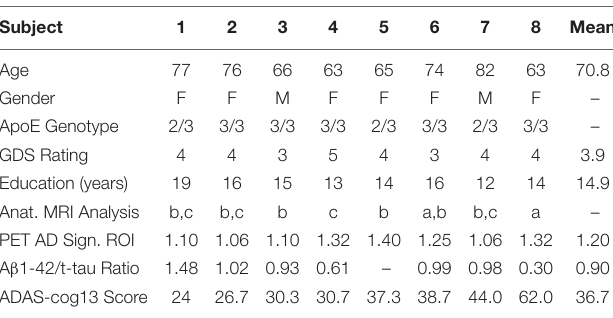
TABLE 1 | Subject